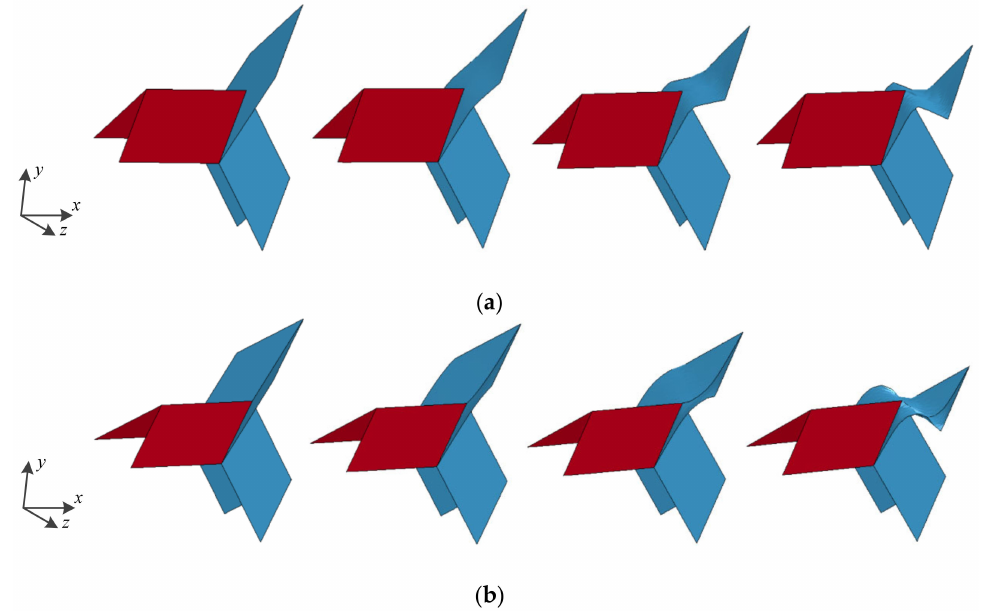
Figure 14. In-plane crushing deformation of Y-cellular cell along the y coordinate when ( a ) r = 6.22 mm and θ = π /3, and ( b ) r = 6.22 mm and θ = π